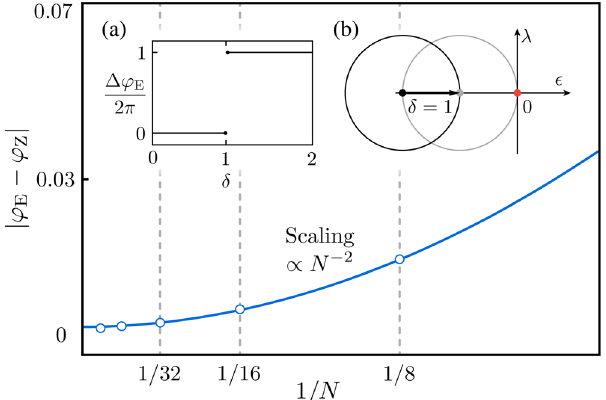
− φ FIG. 3. Scaling of finite-size corrections j φ in the E Z j nonequilibrium analog of the Rice-Mele model introduced in ffiffiffi p 3 Ref. [17], with parameters ϵ ¼ − /4 and λ ¼ − 1 /4 in Eq. (36). As in the thermal case (Fig. 2), the expected scaling behavior approximately N − 2 is verified. Inset (a): Difference ½ 1 / ð 2 π Þ(cid:2) Δ φ E accumulated per full cycle in ð ϵ ; λ Þ parameter space, as a function of a parameter δ controlling whether or not the purity-gap-closing point at ϵ ¼ λ ¼ 0 is encircled [as illustrated in inset (b), with the gapless point shown in red]. As in the thermal case, quantization is observed irrespective of system size N , and a topological phase transition occurs at δ ¼ 1 , where the purity-gap-closing point becomes